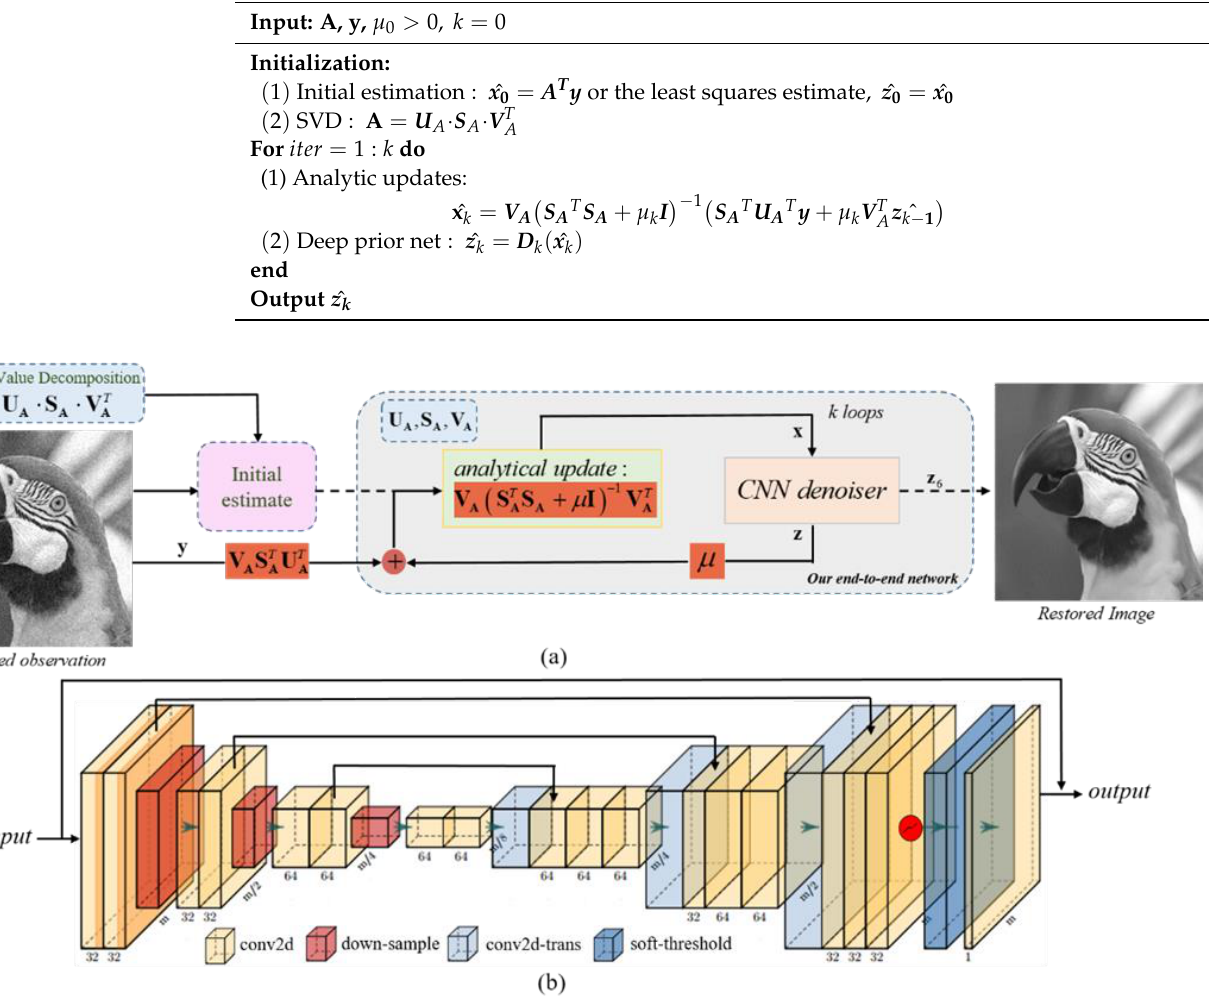
Figure 1. Overview of our proposed method for image restoration. ( a ) The architecture of the proposed deep priors-based deep analytic network. ( b ) The structure of the deep prior network used in our method.